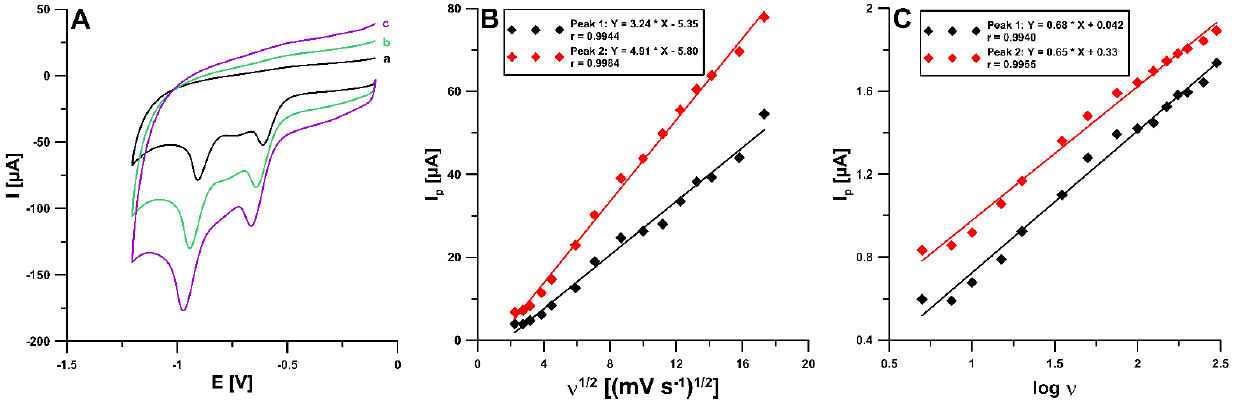
Figure 4. ( A ) Cyclic voltammograms of 0.01 M HNO 3 at the SPCE/SDS for ν of 50 (a), 100 (b), and 150 (c) mV/s. ( B ) The relationship between I p and ν 1/2 for ν from 5 to 300 mV/s. ( C ) The relationship between I p and log ν for ν from 5 to 300 mV/s.